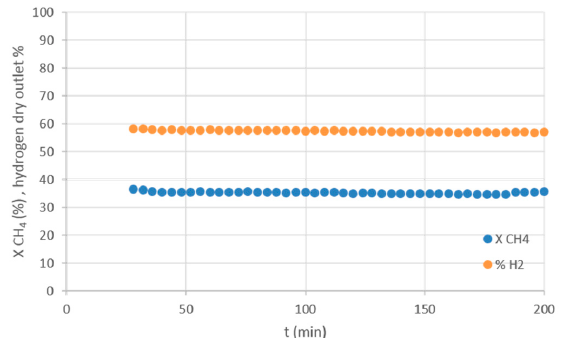
Figure 15. Methane conversion and hydrogen concentration in the dry gas obtained on Rh0.0.5-IWI-R-CZOm tested at 750 °C, 30,000 h − 1 , 1 atm and S/C 1.5.